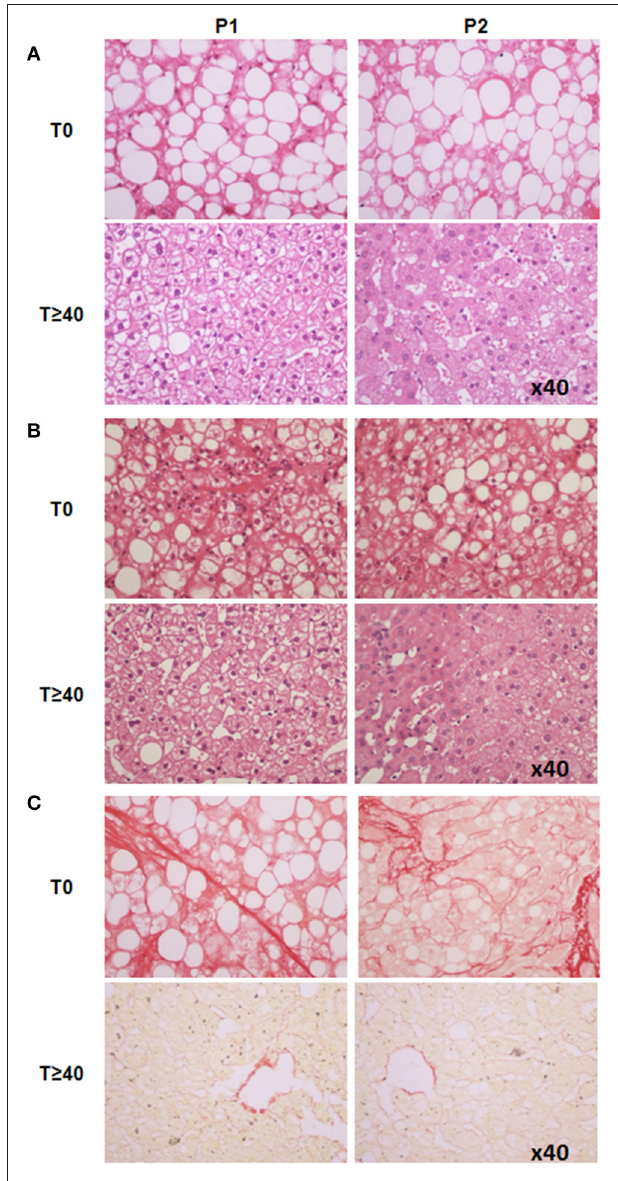
FIGURE 1 | Liver histology analysis of two representative patients (P1 and P2) at baseline and ≥ 40-months after LRYGB. (A) Liver steatosis was improved (HES staining, x40). (B) Ballooned hepatocytes and hepatic inflammation, both present at baseline, were no longer present on the second liver biopsy (HES staining, x40). (C) P1 had bridging fibrosis ( F = 3), P2 had zone three sinusoidal fibrosis and peri-portal sinusoidal fibrosis ( F = 2).